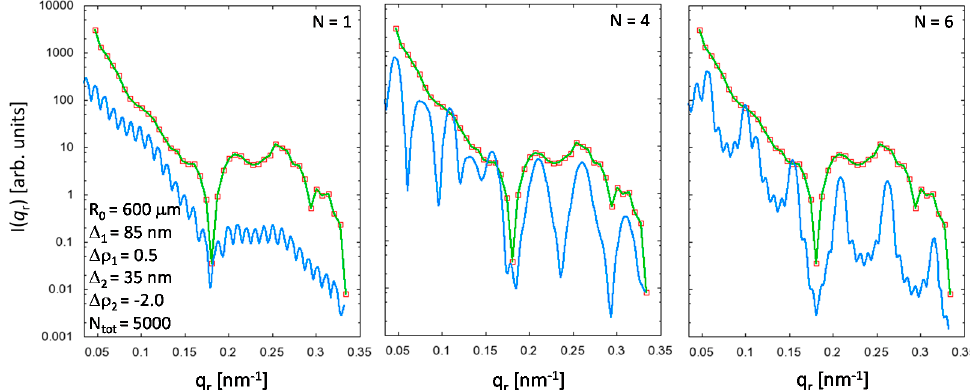
Figure 8. Simulated SAXS intensities (blue solid lines) in comparison with the observed data (symbols and green solid lines) for the sample POF1 using the structure parameters displayed in the inset on the left for different numbers N of repeat units. For better visibility, high-frequency oscillations in the model SAXS curves were suppressed by a seven-point moving average. The model curve with N = 6 repeat units reproduces the positions of the maxima and minima in the measured data quite well. A POF1 sample consisting of only one single repeat unit ( N = 1) is not very likely.